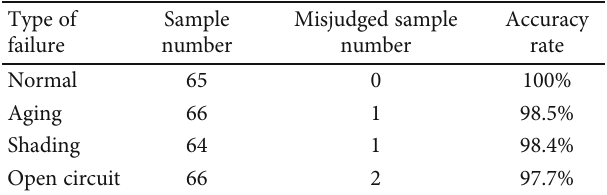
Table 3: Fault diagnosis accuracy